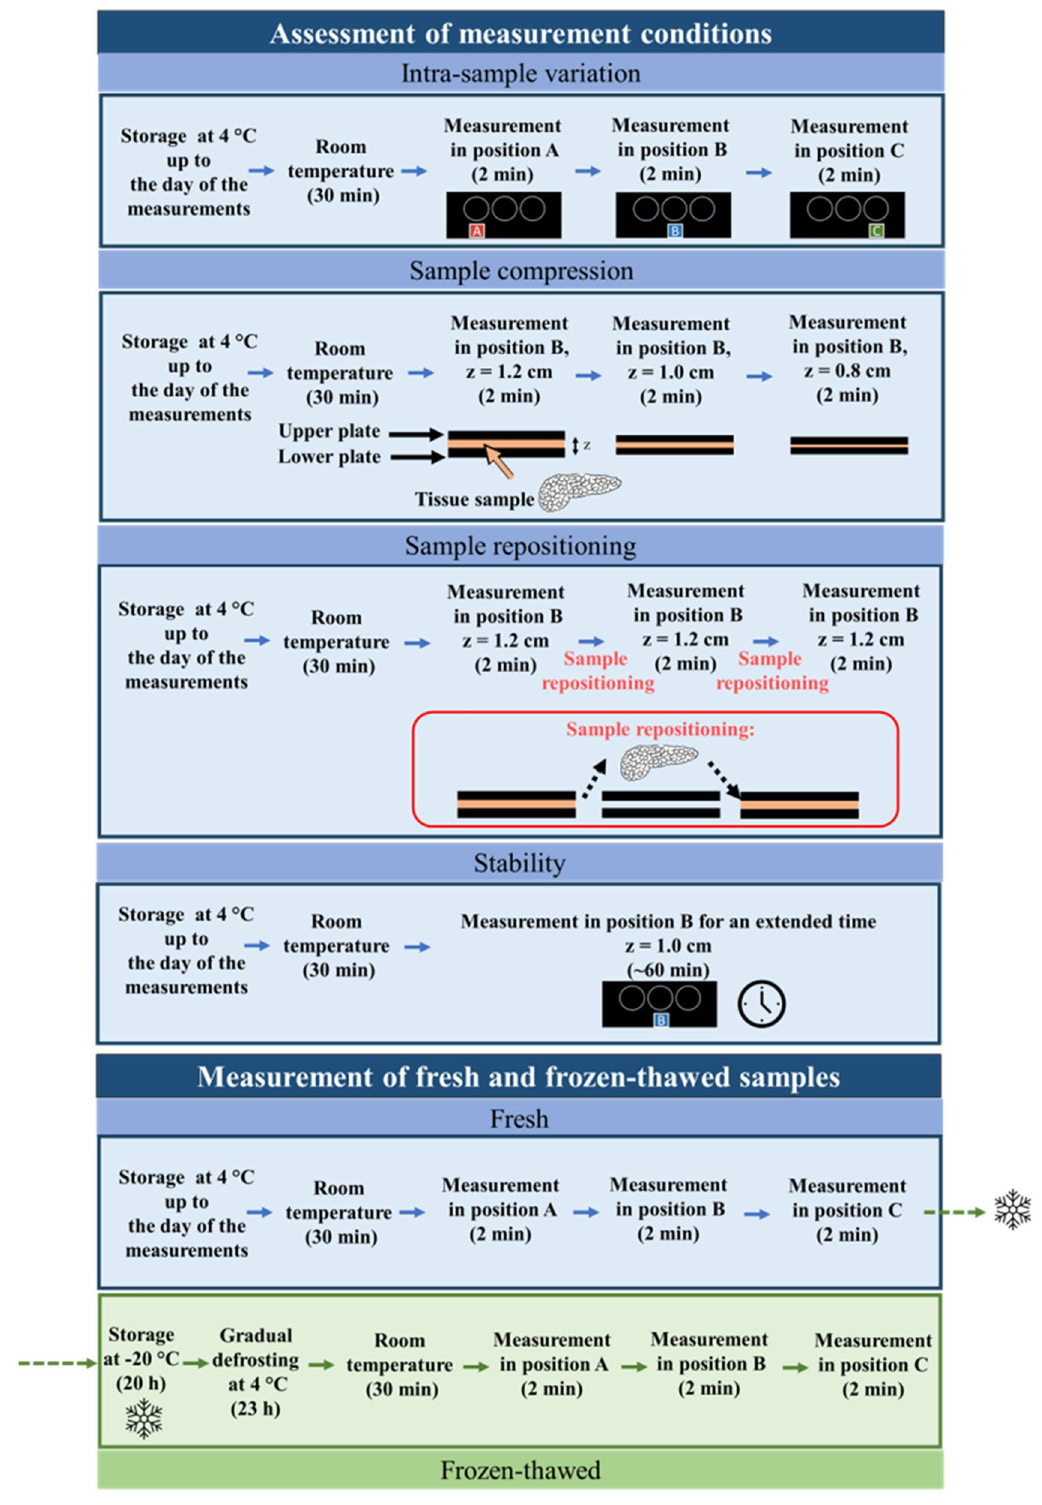
Figure 6. Schematic of the experimental protocol utilized for the assessment of the influence of the measurement conditions on the recovered optical properties and the estimation of the optical properties of the fresh and frozen-thawed